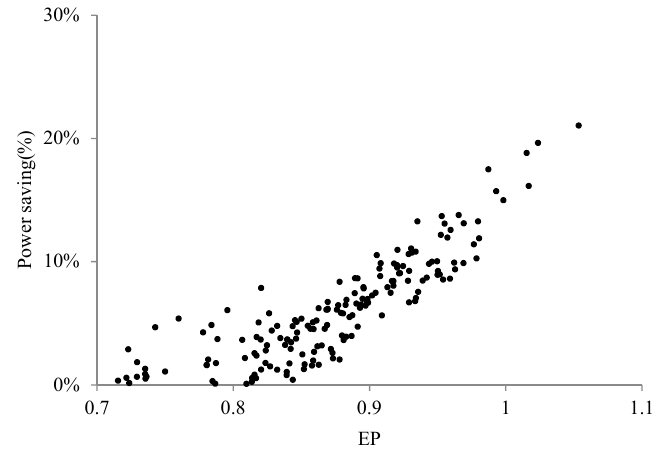
Figure 8. Scattering of power saving and EP.